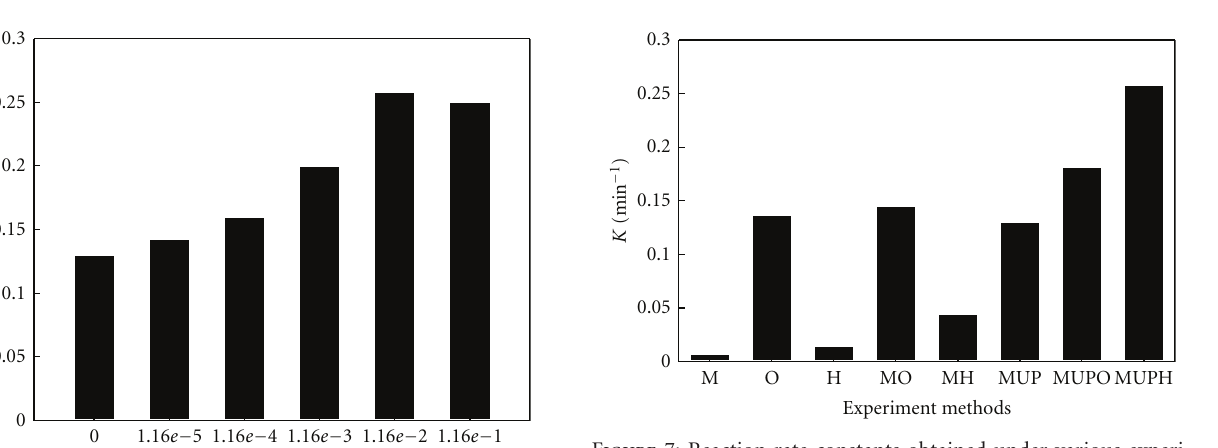
Figure 7: Reaction rate constants obtained under various experi- mental